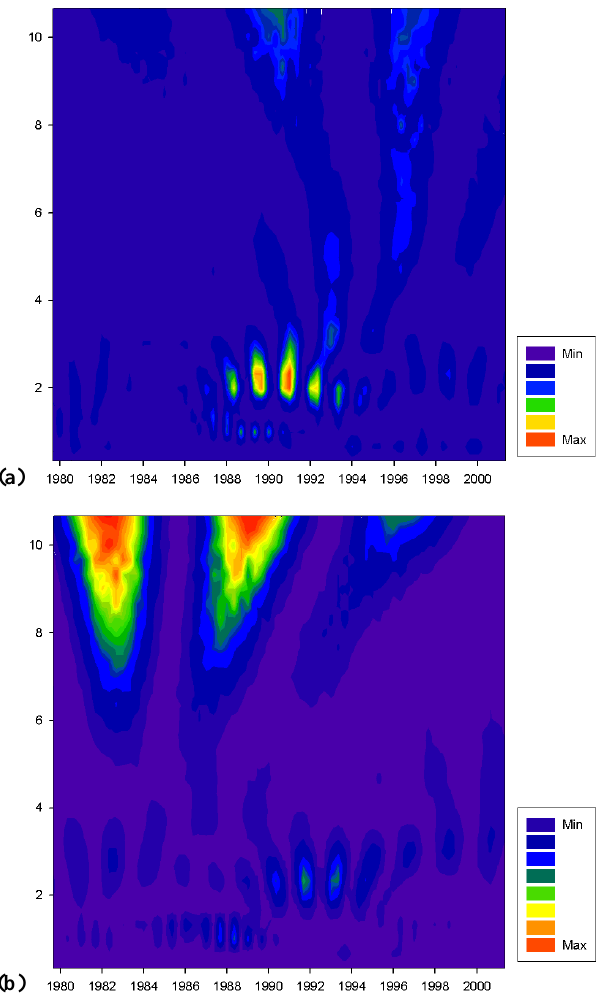
Fig. 5. The wavelet power spectrum (dimensionless) of the (a) spring NAO index and (b) wind gust expansion coefficient time series corresponding to Fig. 4c (continuous line). The y-axis represents the variability scale (years) and the x-axis corresponds to the time period. This figure is available in colour